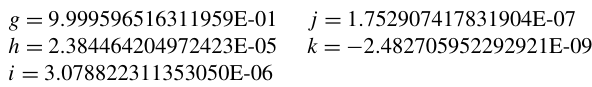
Table A3. Height dependence of six action spectra. Action